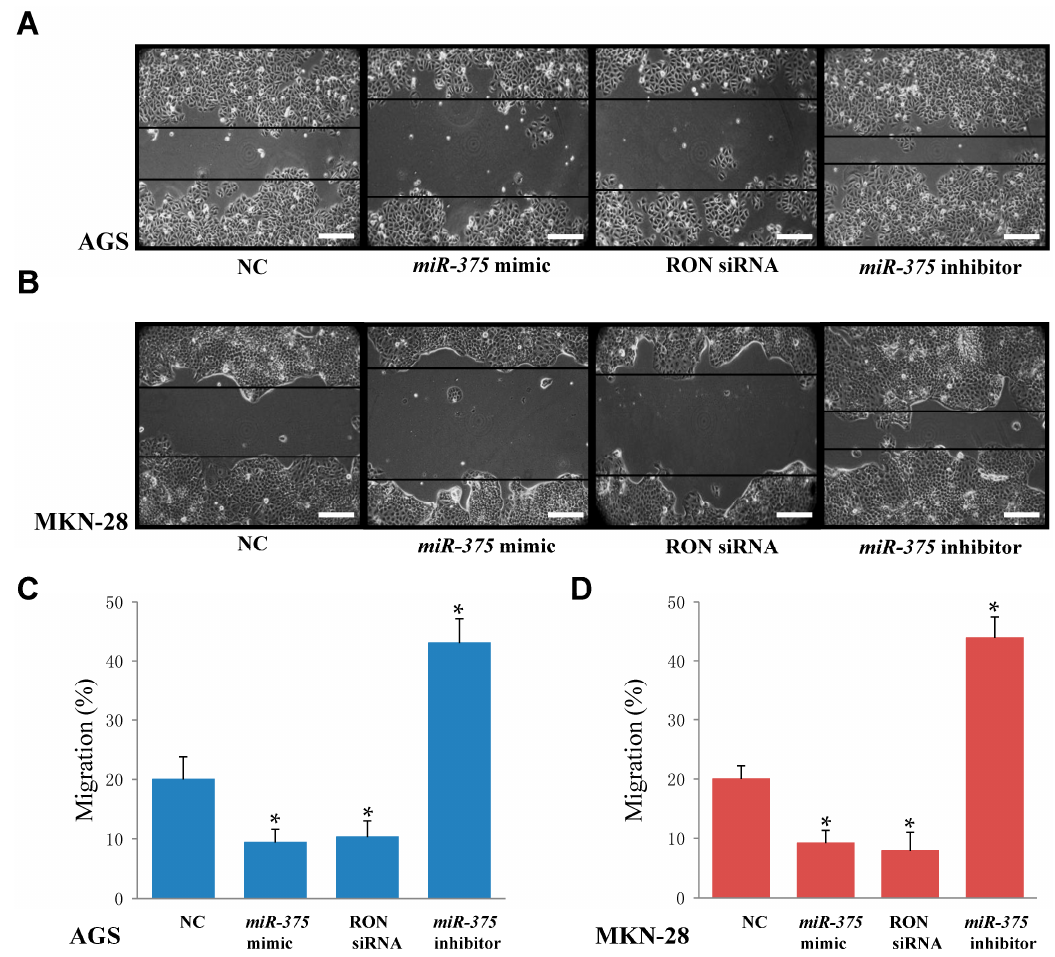
Figure 5. Overexpression of miR-375 or knockdown of RON inhibits cell migration in AGS and MKN-28 cells. ( A , C ) Wound healing assays were performed to evaluate the effect of miR-375 or RON on the migratory ability of AGS cells; ( B , D ) Wound healing assays were performed to evaluate the effect of miR-375 or RON on the migratory ability of MKN-28 cells. * p < 0.05 versus negative control; The data represent the mean ± SD from triplicate measurements. Scale bars: 100 μ M in ( A , B ). The space between back lines in ( A , B ) were measured for the migratory ability of cells.